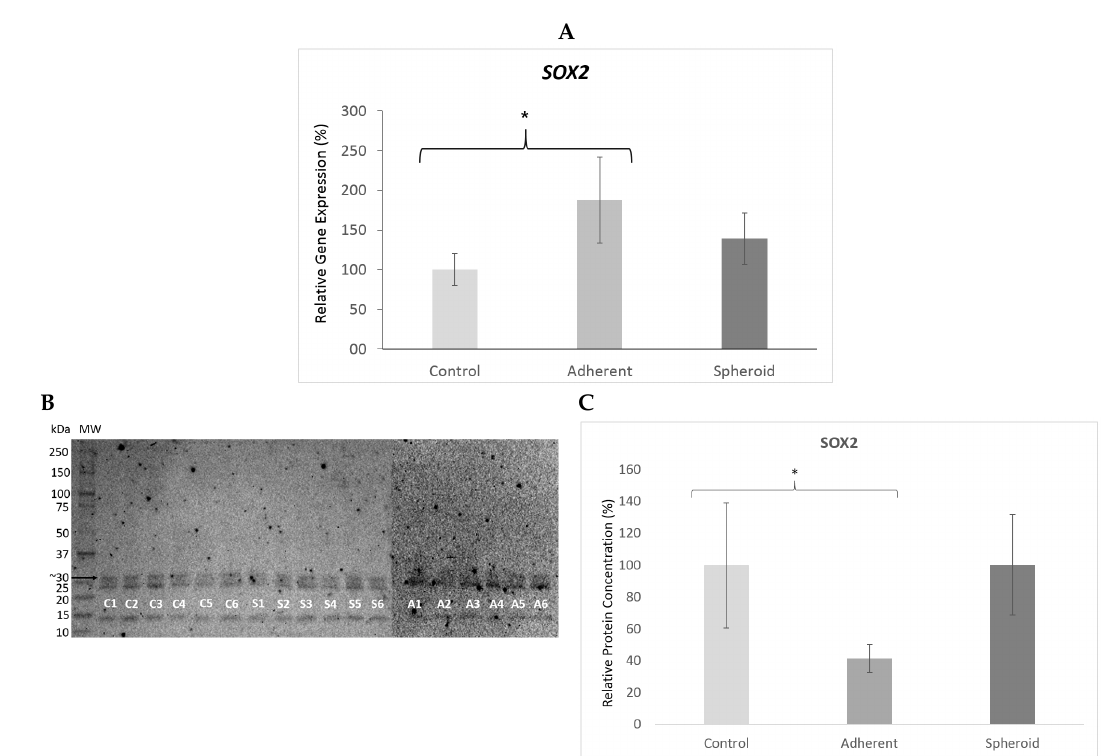
Figure 9. ( A ) SOX2 gene expression was significantly upregulated in the adherent cells under simulated microgravity (1.9 × , * p < 0.05). Upregulation did not reach statistical significance in the spheroids (1.4 × , n.s.). ( B ) Western blot bands showing SOX2 protein production (molecular weight 34 kD). Each lane 1–6 shows protein from one independent experiment (C: 1-g control, S: spheroids, A: adherent cells under simulated microgravity). The bar graph below shows the average density of the blots from the respective experimental group (controls, adherent cells under simulated microgravity, spheroids). SOX2 protein production was significantly lowered in the adherent cells under simulated microgravity ( p < 0.05) and showed no significant change in the spheroids. ( C) Mean intensity of the bands in the respective group, intensity of controls defined as